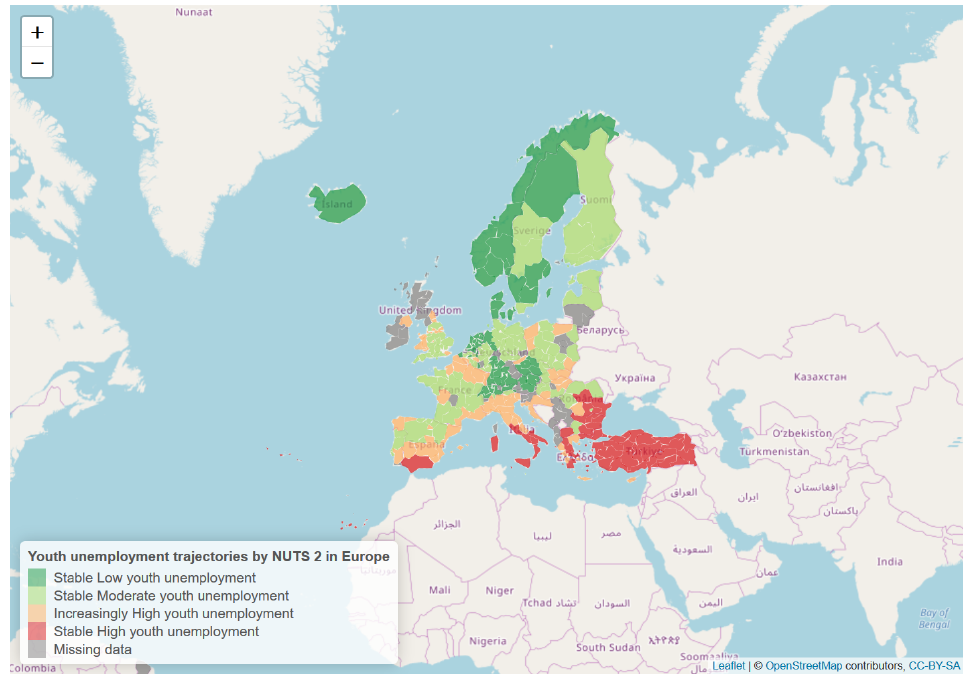
Figure 6: Interactive map of youth unemployment trajectories in NUTS 2 from 2008 to